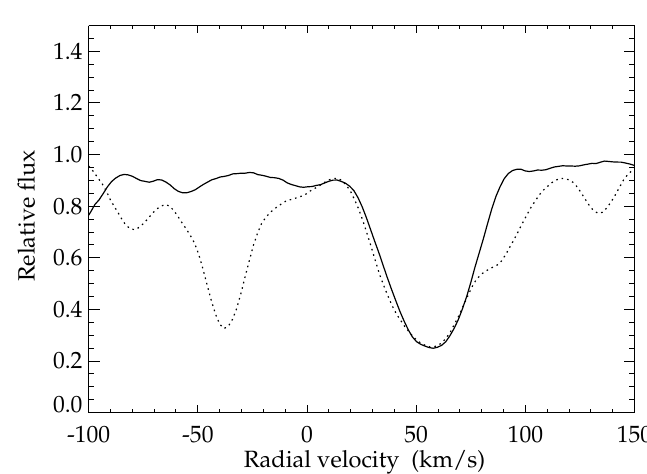
Fig. 6. The H α (solid line) and H β (dotted line) lines in the spectrum of R Sct obtained at SAO on JD = 2455464.3 and JD =